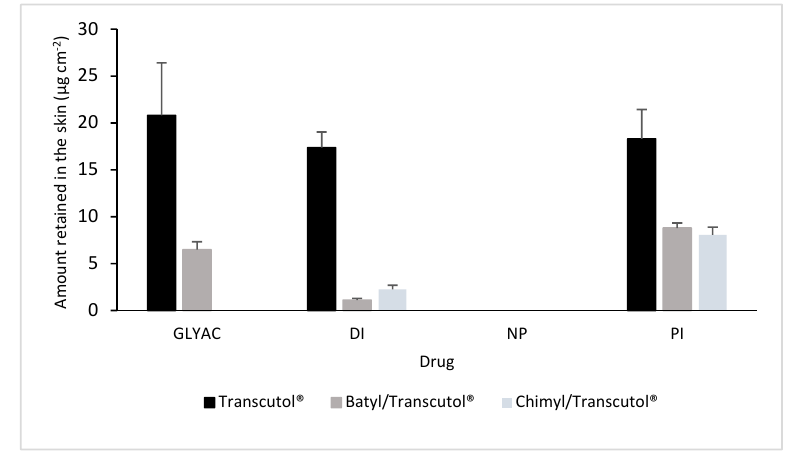
Figure 4. Amount of drug retained in the skin ( µ g · cm − 2 ) after the permeation experiments using Transcutol ® , batyl alcohol/Transcutol ®, and chimyl alcohol/Transcutol ® as solvents for the drugs. GLYAC = glycyrrhizic acid; DI = diclofenac; NP = naproxen; PI = piroxicam. p < 0.05 (Transcutol ® vs. batyl or chimyl) by comparing each drug separately; p < 0.05 for batyl vs. chimyl, with the exception of PI. 2.2. TEWL Measurement